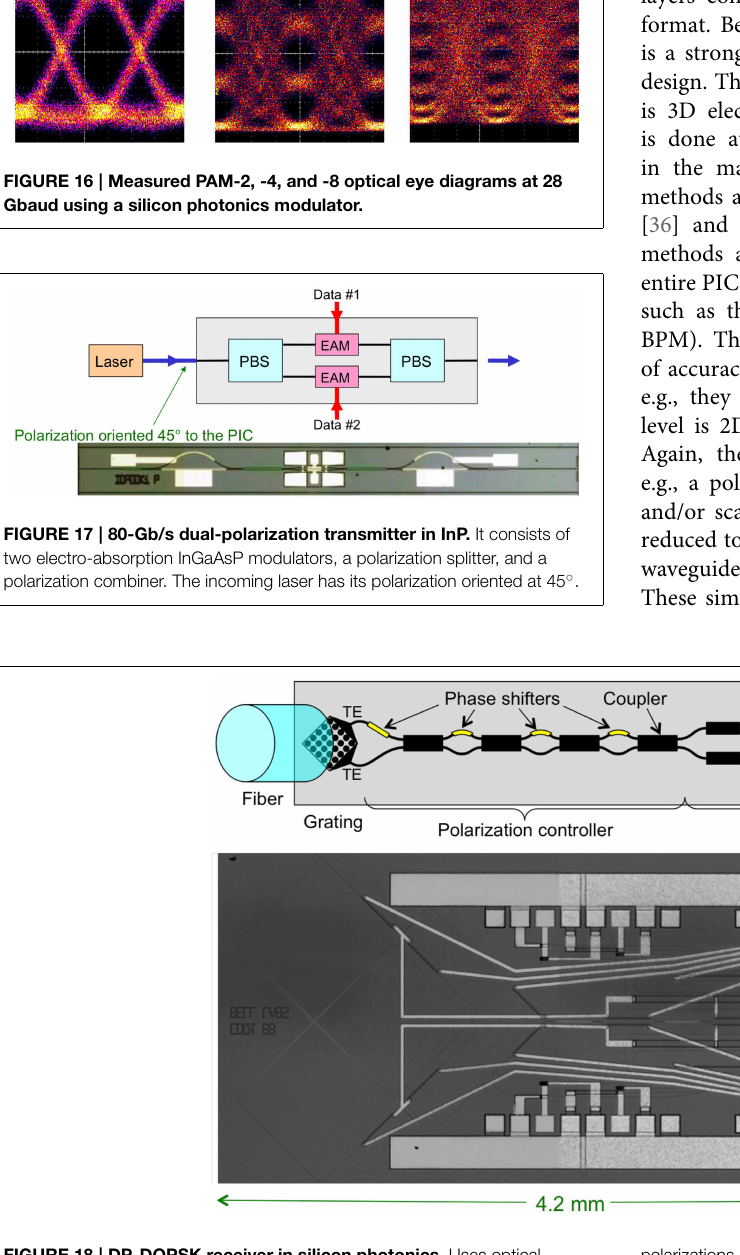
Frontiers in Physics |